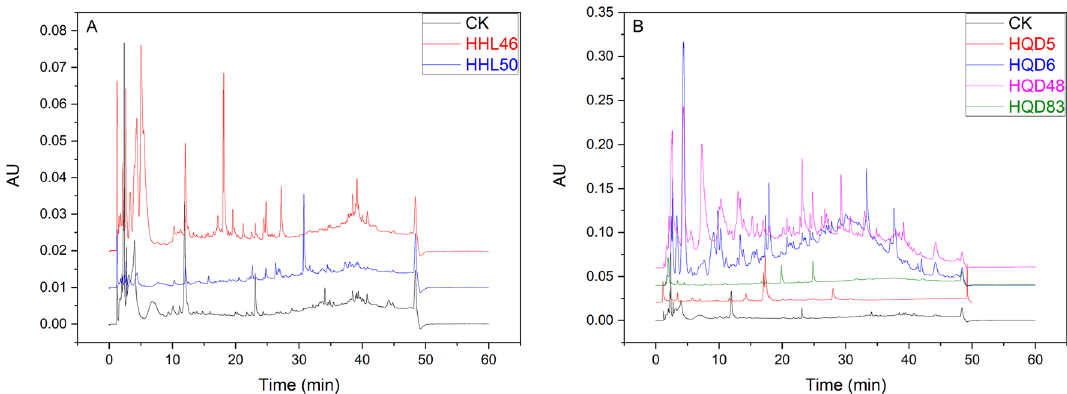
Figure 3. HPLC chromatogram fermented endophytic fungi produced in rice medium (RM) fermentation. ( A ) Shows the chromatograms of fermented product grown on the RM at 254 nm for 2 endophytic fungi of R. stylosa (HHL46 and HHL50) with strong bioactive abilities and the extraction of RM as control. ( B ) Shows the chromatograms of fermented product grown on the RM at 254 nm for 4 endophytic fungi of R. mucronata (HQD5, HQD6, HQD48 and HQD83) with strong bioactive abilities and the extraction of RM as control. Among them CK means, control check, the result of HPLC from the extraction of rice